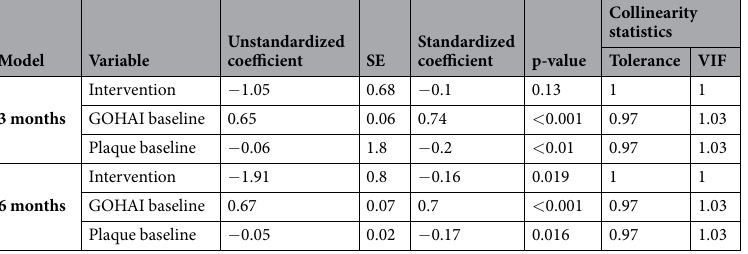
Table 1. Factors associated with GOHAI (linear regression). 3-month final model: adjusted R square = 0.64. 6-month final model: adjusted R square (model 3) = 0.57.